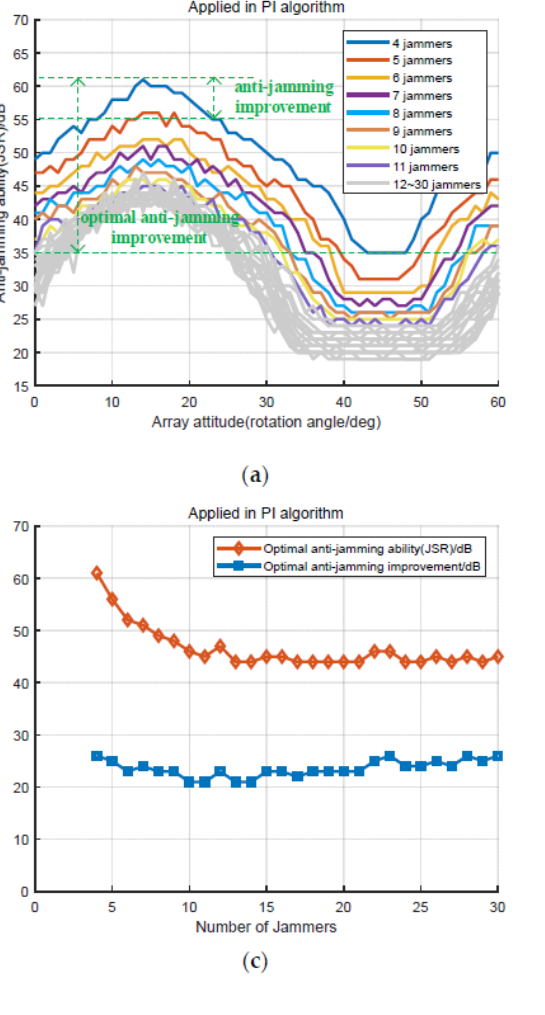
Figure 10. Anti-jamming ability of rotating antenna array algorithm. ( a ) The anti-jamming ability of the PI algorithm for arbitrary (azimuth) antenna array attitude. ( b ) The anti-jamming ability of the MVDR algorithm for arbitrary (azimuth) antenna array attitude. ( c ) Array anti-jamming abilities and their maximum improvements applying the proposed method to the PI algorithm. ( d ) Array anti-jamming abilities and their maximum improvements applying the proposed method to the MVDR